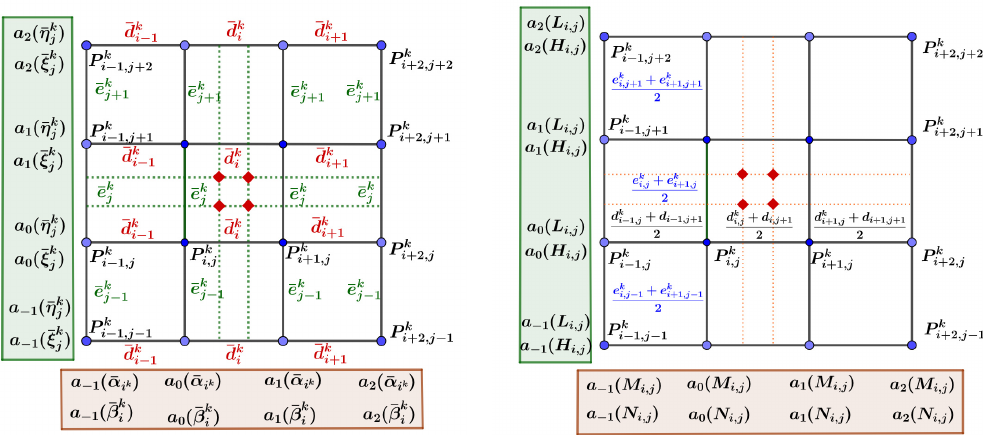
Figure 5. Mask parameterization of surface subdivision. Left: global non-uniform parameterization of surface subdivision Right: local non-uniform parameterization of surface subdivision.